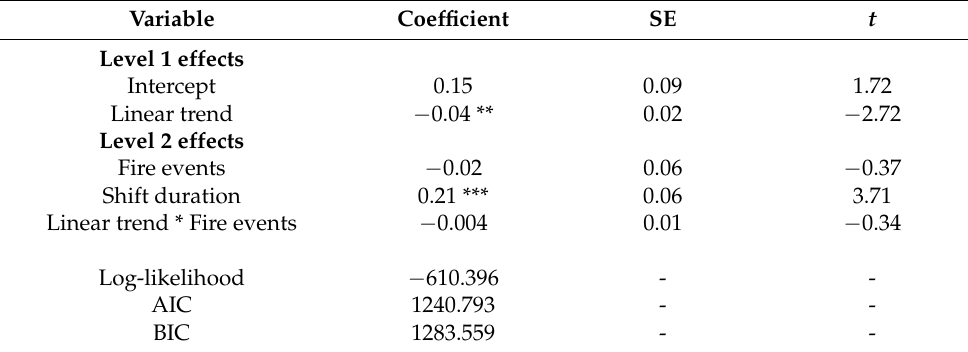
Table 3. Fire Event’s Occurrence Predicting Change in Emotional Exhaustion.